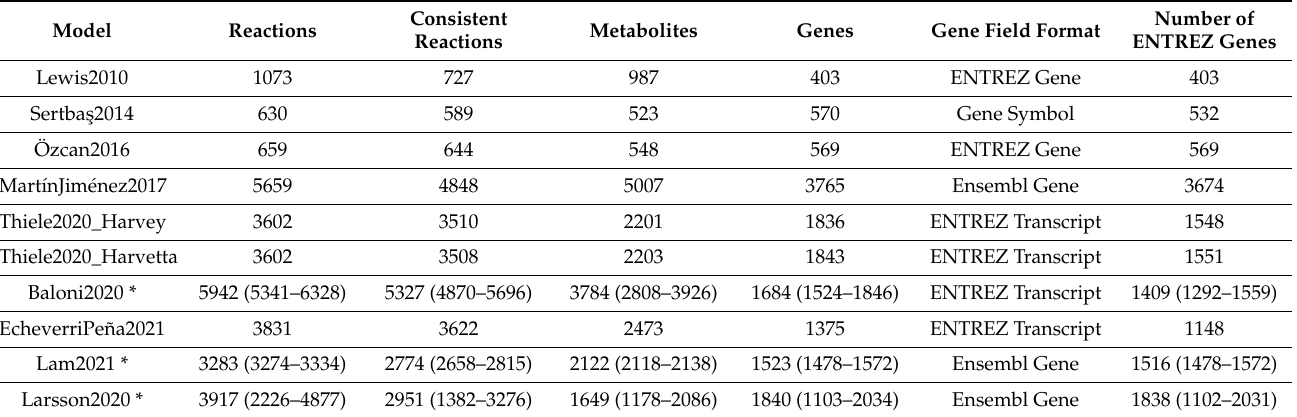
Table 2. Model statistics for the brain GEMs. The curated and semi-curated models were retrieved as explained in Supplementary File S1 Table S1. For studies with more than two models (Larsson2020, Baloni2020 and Lam2021), the median sizes and range were computed. The number of reactions was determined for consistent models of these studies using FASTCC [79]. Since the models used different gene identifiers, the identifiers were mapped to ENTREZ